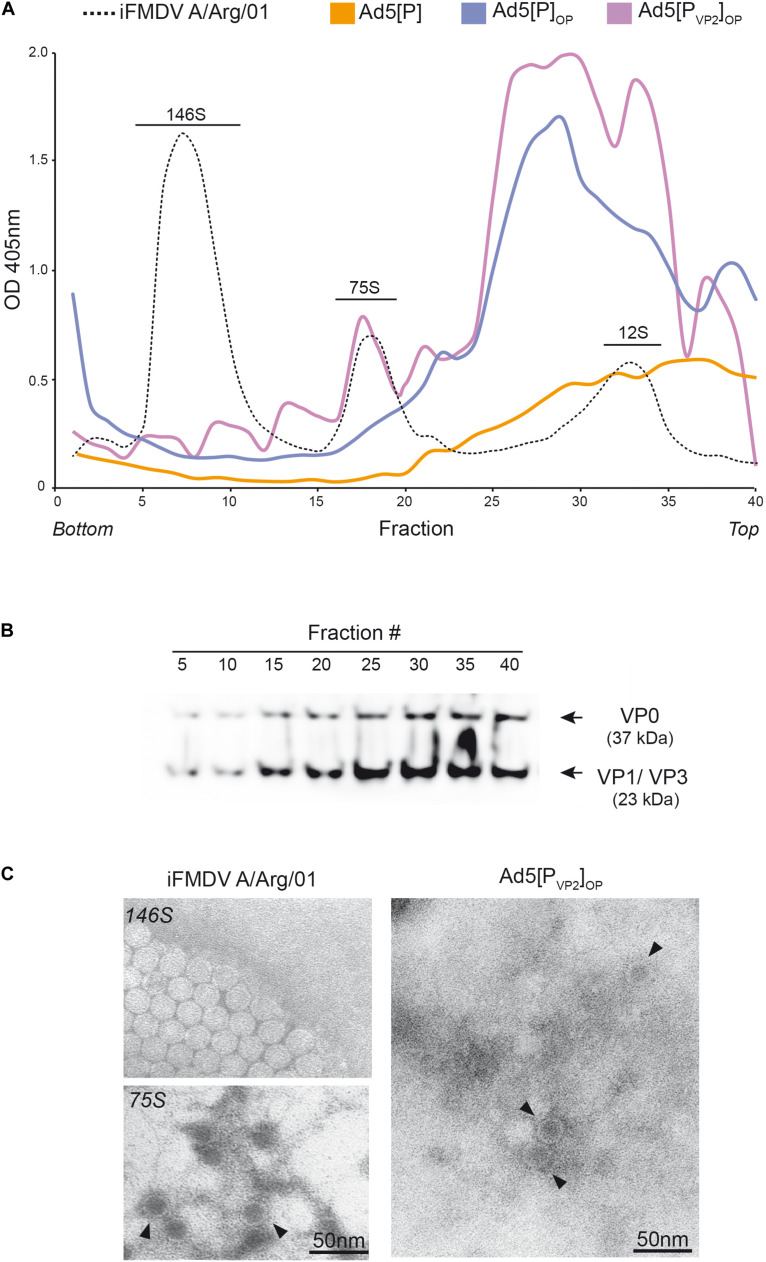
Assembly of recombinant capsid proteins into subviral particles. (A) Lysates of HEK 293A cells infected with Ad5[P], Ad5[P]OP, or Ad5[PVP2]OP were loaded onto 10–45% sucrose gradients. Inactivated native A/Argentina/2001 foot-and-mouth disease virus (iFMDV A/Arg/01) was also included as a marker (black dotted line). Fractions were collected after centrifugation at high speed and analyzed by ELISA. The positions of the FMDV virions (146S), empty capsids (75S), and capsomers (12S) are indicated. (B) Eight fractions (5, 10, 15, 20, 25, 30, 35, and 40) were analyzed by Western blot with specific anti-FMDV O1/Campos polyclonal antibody. VP0 and VP1/VP3 are indicated with an arrow. (C) Negative-staining TEM of in situ generated FMDV empty capsid particles (right) and iFMDV 146S and 75S particles (left). Scale bar, 50 nm. Virus-like particles are indicated (filled inverted triangle).